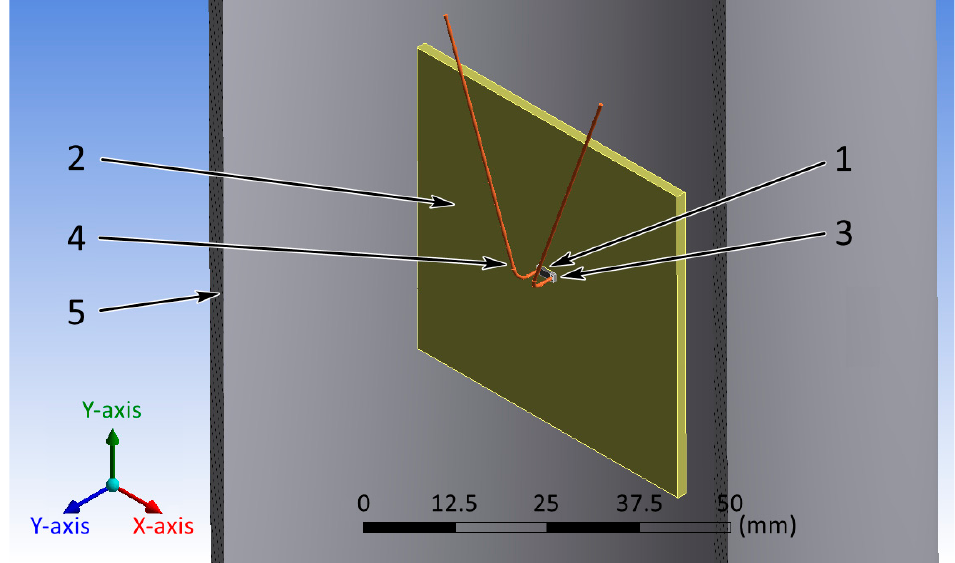
Figure 4. Cross-section of the final view of the geometric model: 1—component; 2—base; 3—solder; 4—wire;